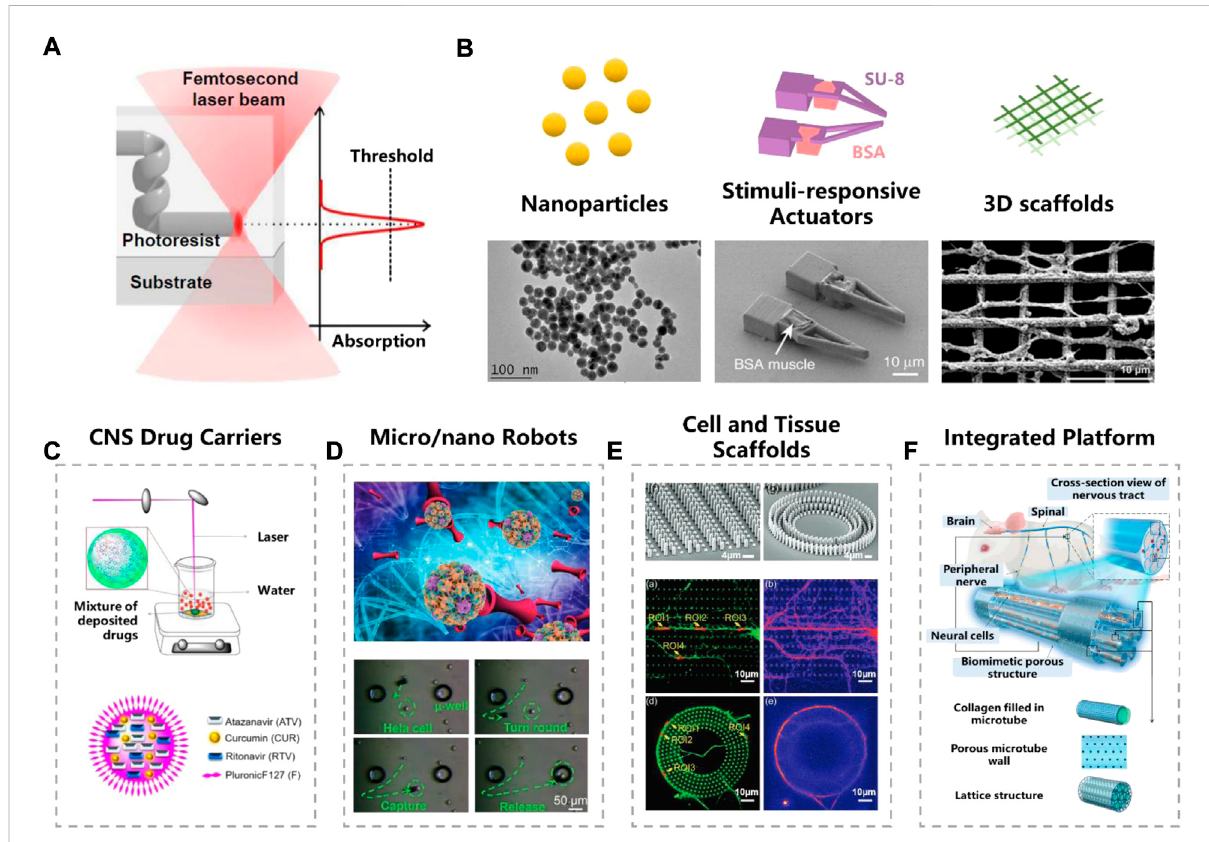
FIGURE 1 Femtosecond laser fabrication in neurobiological research. (A) Femtosecond laser nonlinear absorption mechanism. Reproduced from (Harinarayana and Shin, 2021) with permission of Elsevier. (B) Typical micro/nano structures fabricated by femtosecond laser. Reproduced from (Bailly et al., 2019) (Ma et al., 2020) with permission of Springer Nature. Reproduced from (Agrawal et al., 2021) with permission of Elsevier. (C – E) Functional units fabricated by femtosecond laser. (C) CNS drug carriers. Reproduced from (Singh et al., 2020) with permission of Elsevier. (D) Micro/nano robots. Reproduced from (Yang et al., 2019) with permission of Wiley-VCH. (E) Cell and tissue scaffolds. Reproduced from (Fan et al., 2021) with permission of Wiley-VCH. (F) Integrated platform. Reproduced from (Wei et al., 2022) with permission of Royal Society of